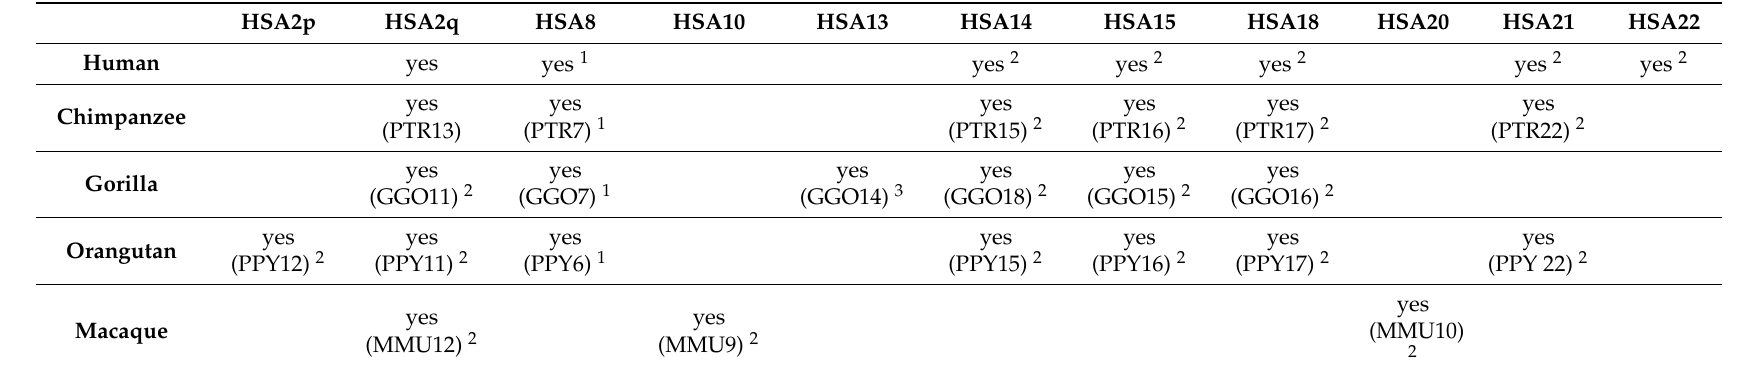
Table 4. FISH results obtained from hybridizing human fosmid clones containing POTE sequences (ABC12-49207800H13, ABC12-49059300N17, ABC12-46762300H6, ABC8-41159000G3) from human, chimpanzee, gorilla, orangutan, and macaque metaphases. Classical karyotype nomenclature is used for PTR, GGO, and PPY; MMU nomenclature according to Rogers et al.